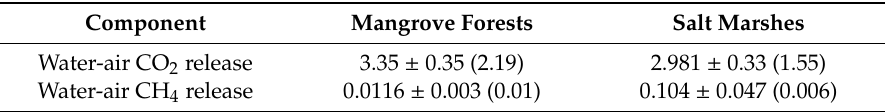
Table 4. Comparison of mean ( ± 1SE) rates of water–air CO 2 and CH 4 emissions between mangrove and salt marsh ecosystems, including open water estuaries containing mangrove and salt marsh habitats. Units = Mg C ha − 1 a − 1 . Median values are in parentheses. Mangrove data from [94,139]. Salt marsh data from [139–152] and references within.